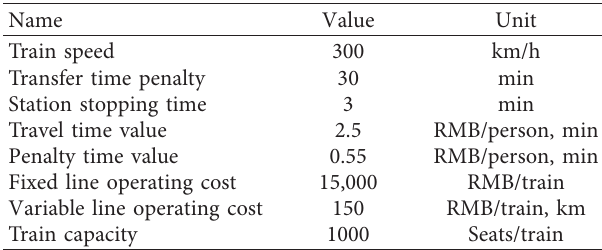
Figure 3: The alternative iterative approach framework for line planning Table 3: Experiment parameter setting.